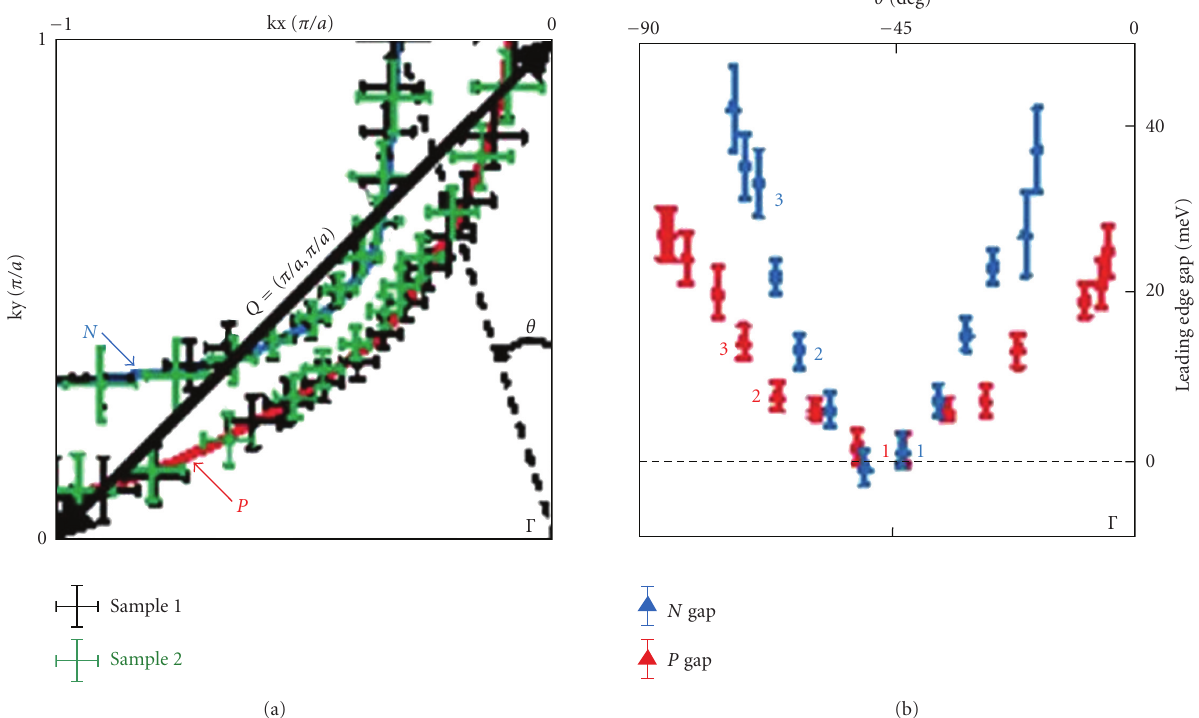
Figure 20: (a) Fermi surface (FS) contours from two samples of F0234. N —electron-like; P —hole-like. Bold arrow is ( π , π ) scattering vector. Angle θ defines the horizontal axis in (b). (b) Leading gap edge along k-space angle from the two FS contours. From [152].